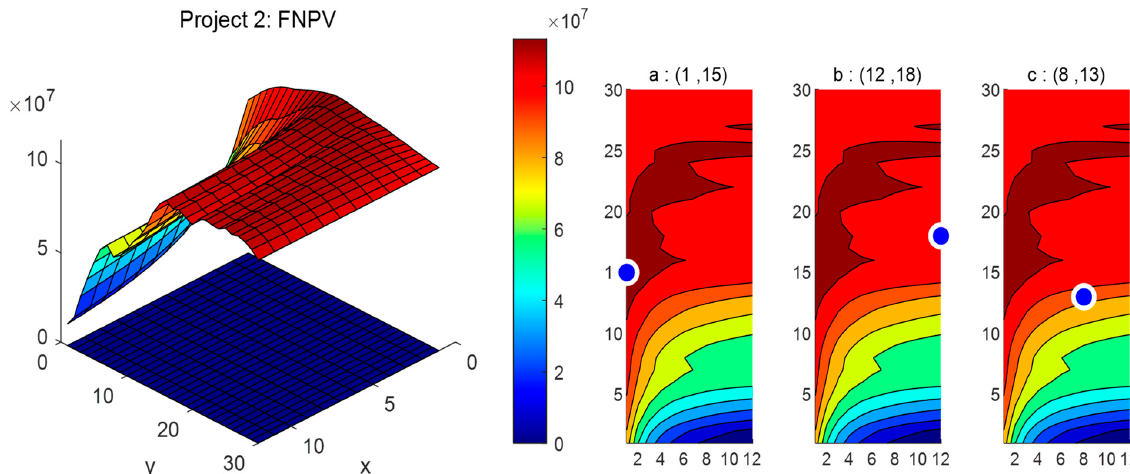
Figure 21. Decision − making for project 2. Figure 21. Decision-making for project 2.